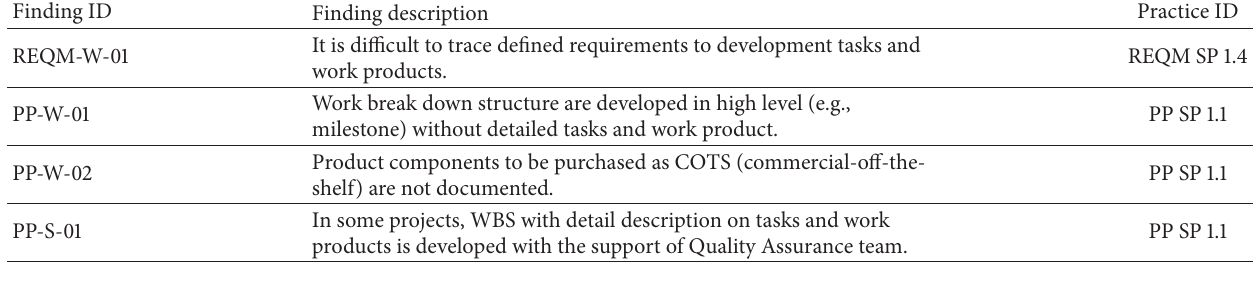
Table 2: Assessment findings and corresponding practices.